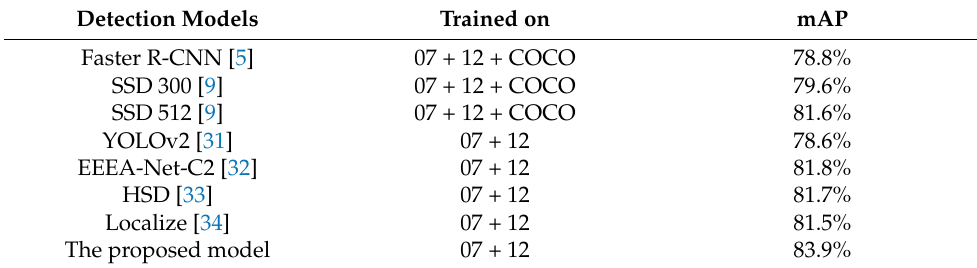
Table 3. Comparative results on the Pascal VOC 2007 testing dataset. Detection